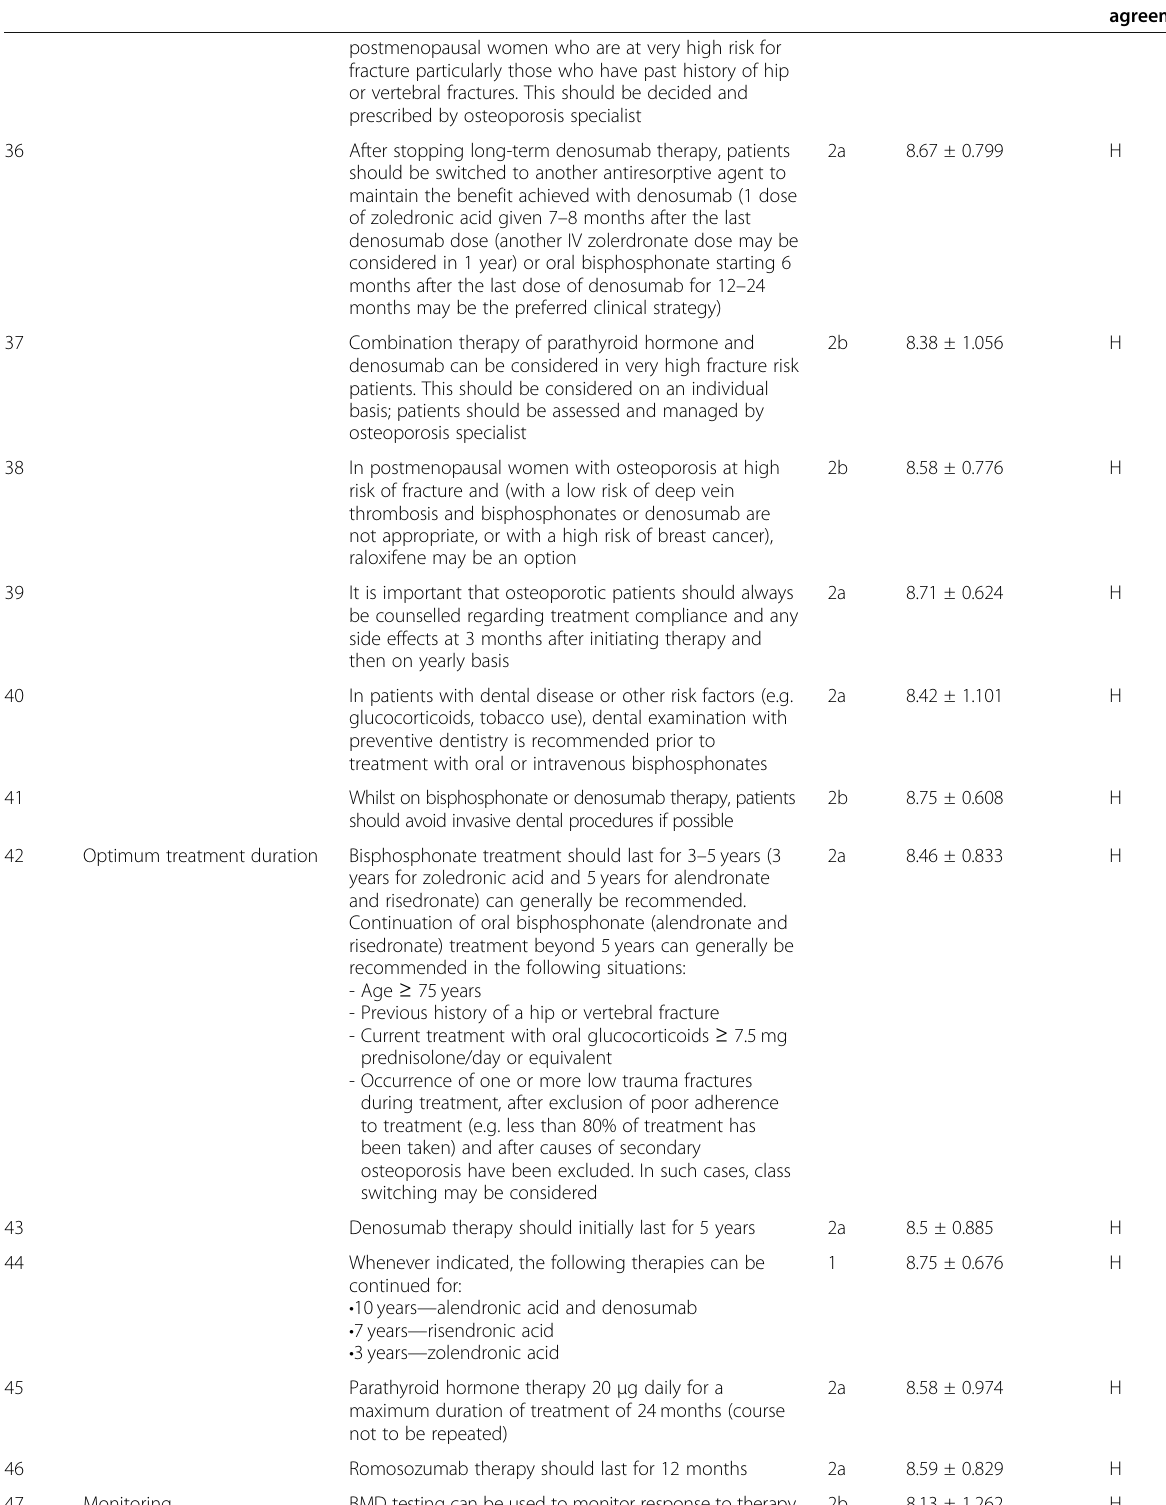
Table 2 Breakdown of statements of recommendations, its individual rank, and level of agreement (Continued)